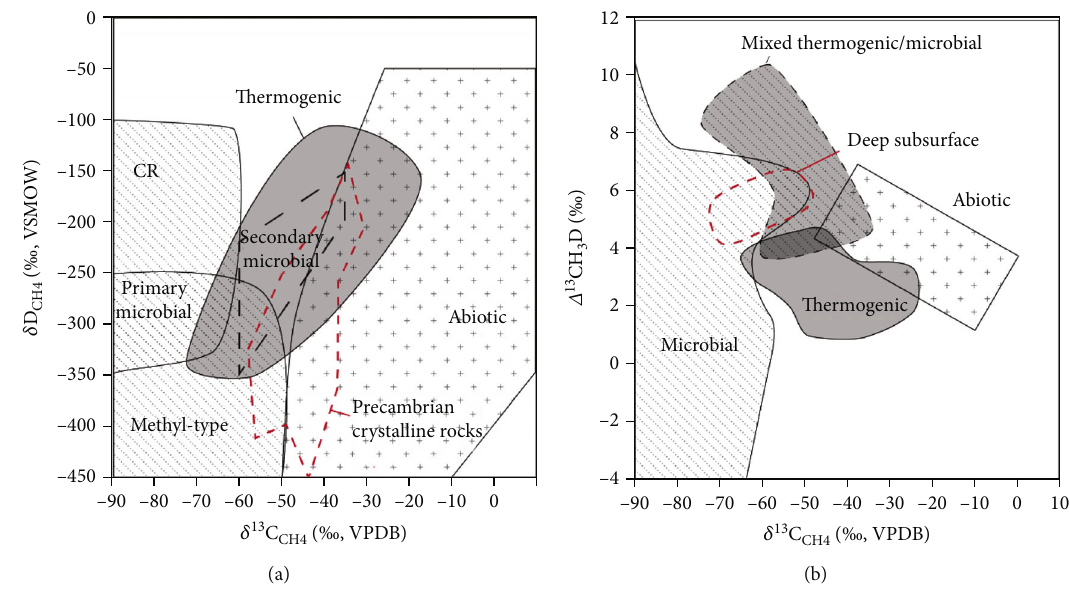
Figure 1: Genetic diagrams showing composition fi elds for methane origins (a) δ 13 C vs δ D based on Milkov and Etiope [12]; Etiope and Schoell [96]; (b) δ 13 C vs clumped isotopes, fi elds based on the fi gure of Douglas et al. [97]. Environmental origin fi eld for “ Deep subsurface ” indicated only for microbial samples. Data from [13, 14, 97 –